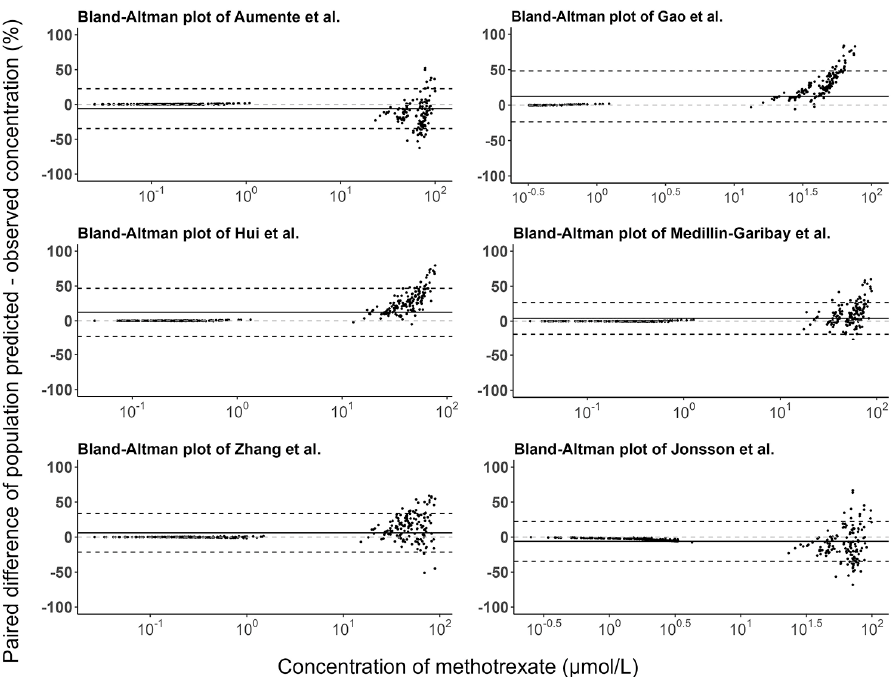
Figure 4. Bland-Altman plots of the prediction errors of population predictions for published population pharmacokinetic models of methotrexate based on an independent dataset in children with acute lymphoid leukemia. The black line is the mean of the population prediction error, and the black dashed lines are the mean ± 1.96 times the standard deviation of the population prediction error